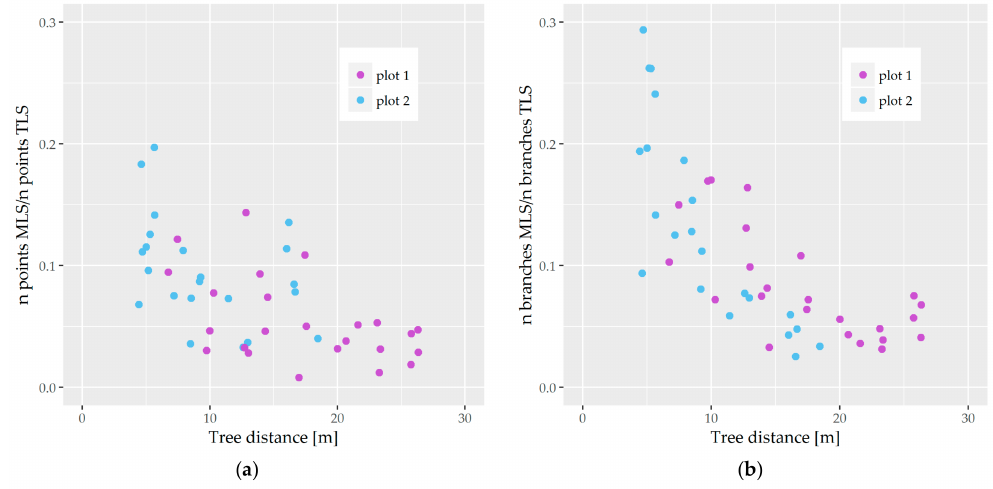
Figure 11. ( a ) Proportion of MLS point number to TLS point number of the segmented tree point clouds as a function of the distance to the MLS trajectory. ( b ) Proportion of extracted branch number of the MLS data to the branch number of the TLS data of the segmented trees as a function of the distance to the MLS trajectory.